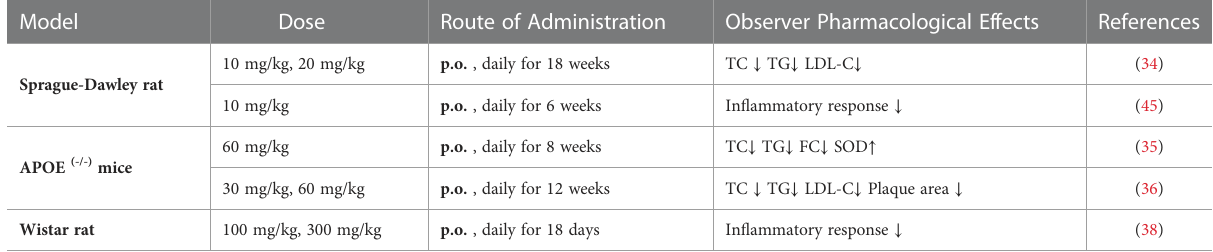
TABLE 1 Anti-atherosclerotic effects-related animal experiments with paeoni fl orin. Model Dose Route of